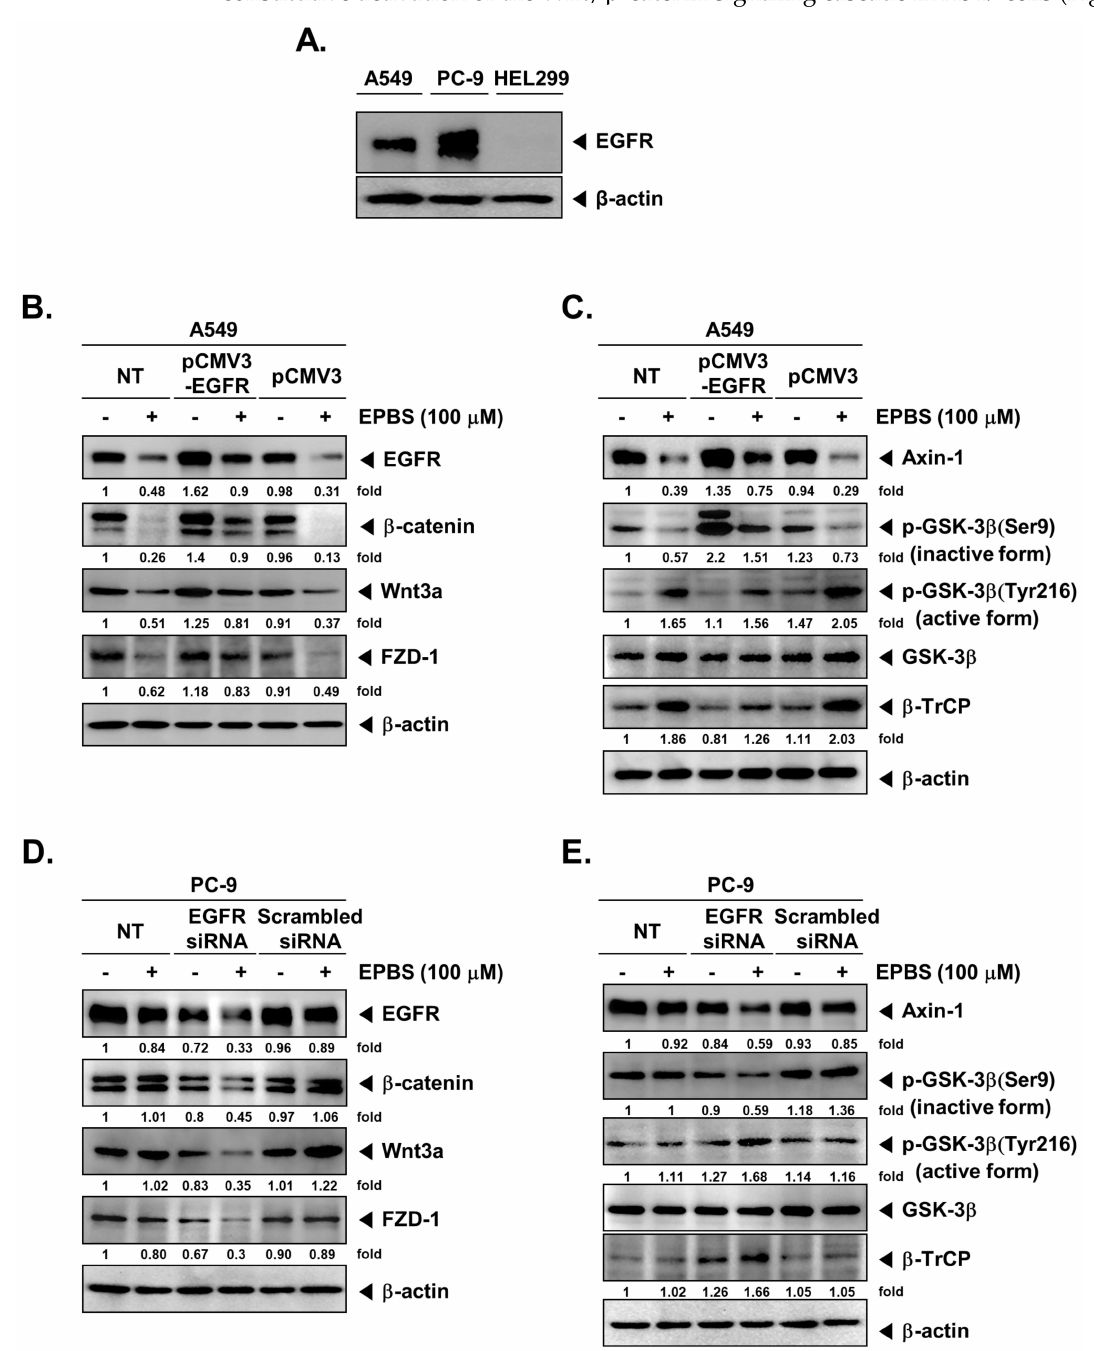
Figure 3. EPBS mitigates the Wnt/ β -catenin signaling pathway in EGFR − overexpressing or EGFR − knockdown NSCLC cells. ( A ) Human NSCLC A549 and PC-9 cells and human normal lung HEL299 cells were seeded on six-well plates (5 × 10 5 cells/well), and then cells were harvested and lysed. Western blot analysis was carried out. ( B , C ) A549 cells were seeded on 24-well plates (8 × 10 4 cells/well). A549 cells were transfected with 300 ng of human EGFR/HER1 gene ORF cDNA clone expression plasmid (pCMV3-EGFR) or pCMV3-untagged negative control vector (pCMV3) with transfection reagent in serum-free medium (SFM) for 24 h. After 24 h, the transfected A549 cells were changed with a complete medium and then treated with 100 µ M of EPBS for 4 h. Western Blot analysis was performed. ( D , E ) PC-9 cells were seeded on 24-well plates (8 × 10 4 cells/well)